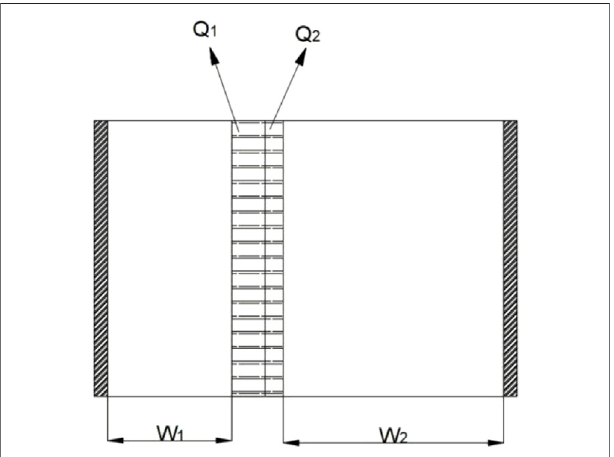
FIGURE 3 | Model diagram of equivalent sub-charge